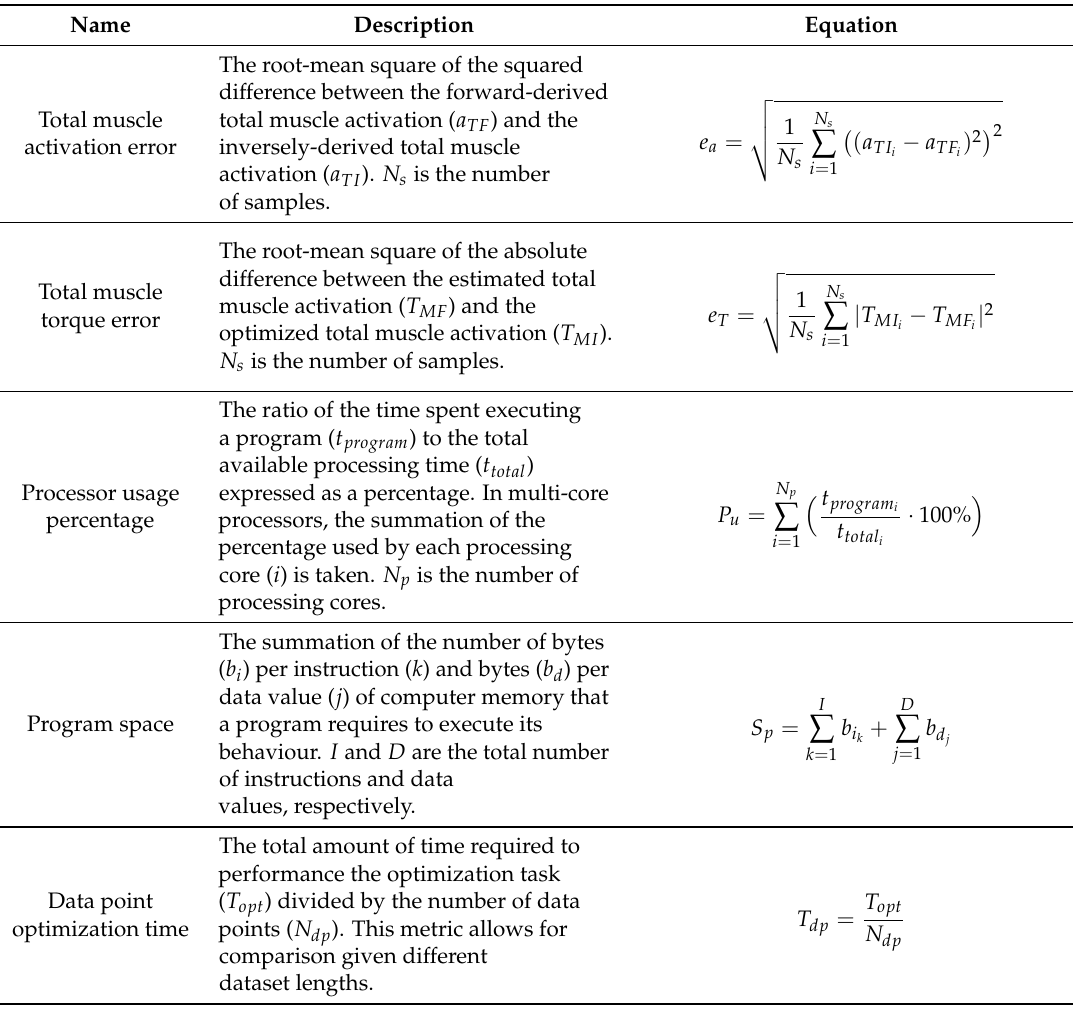
Table 3. Performance metrics suite to compare between accuracy and computational